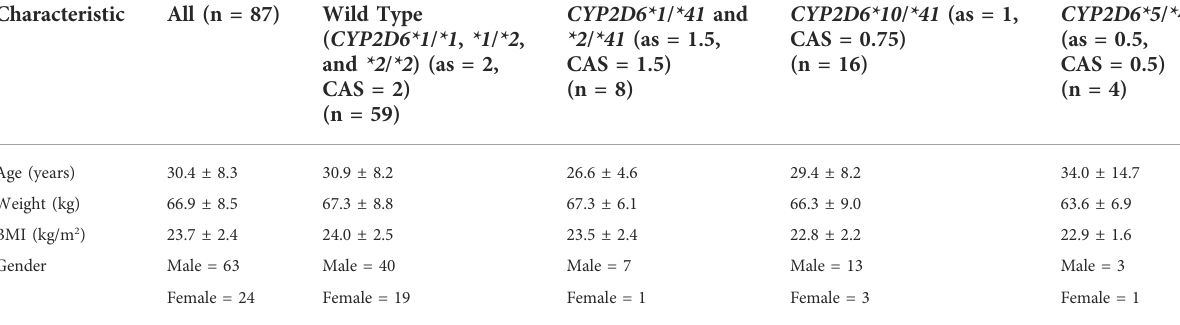
TABLE 1 Demographic characteristics of the study population of healthy Chinese volunteers (mean ± SD). Characteristic